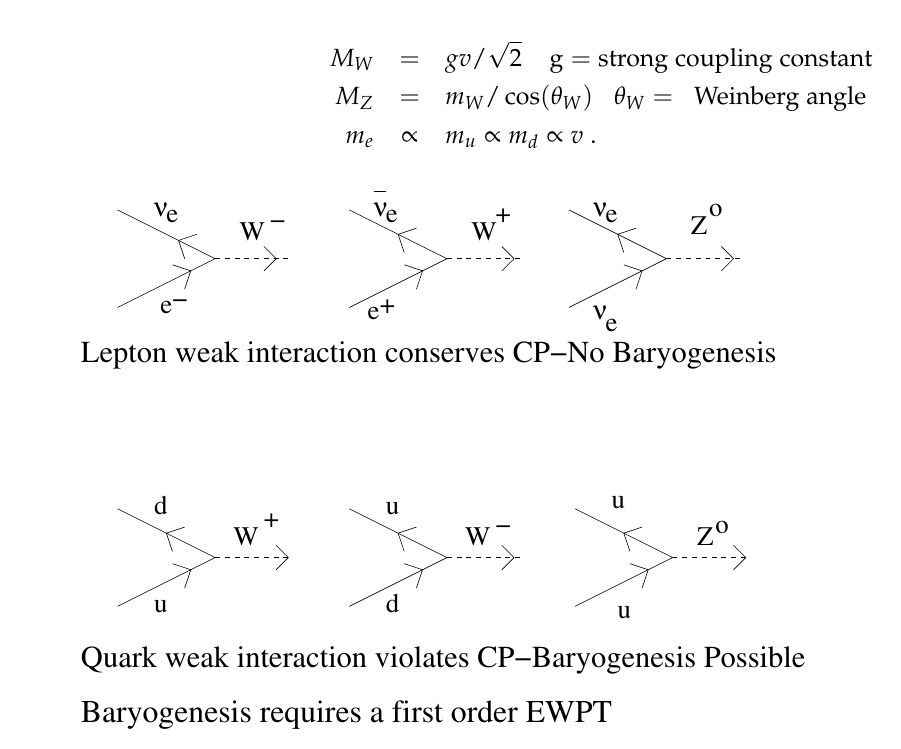
Figure 2. Lepton and Quark weak interactions. Standard model M W = 80 GeV and M Z = 90